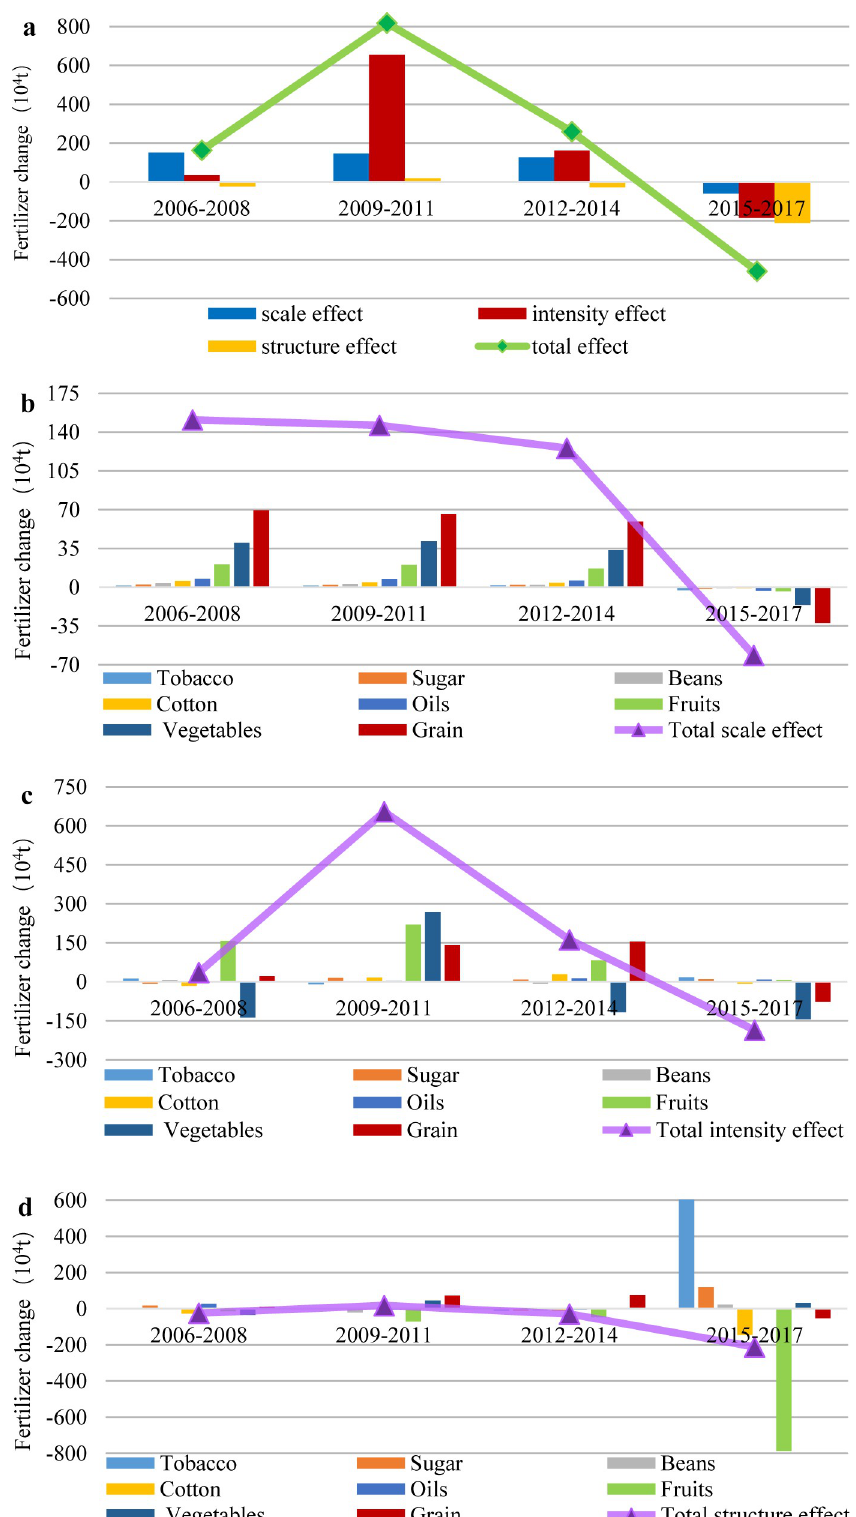
Fig 2. The total effect, scale effect, intensity effect and structure effect based on crop perspective: (a) Chinese FU variation decomposition based on crops;(b) Contributions of key crops to scale effect; (c) Contributions of key crops to intensity effect;(d) Contributions of key crops to structure